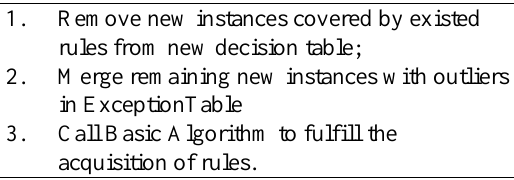
Figure 4. Incremental learning